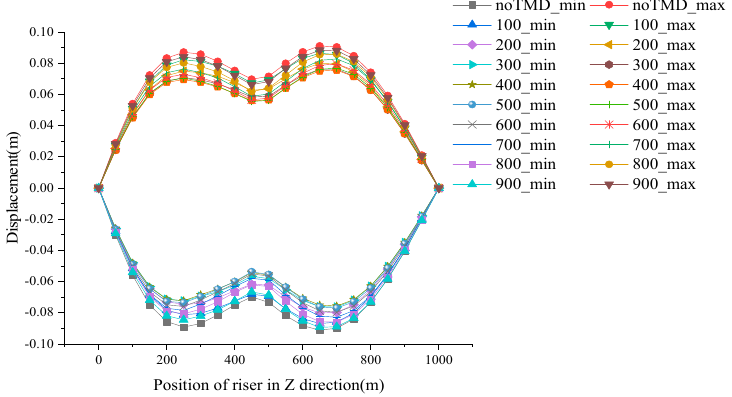
Figure 5. Envelope diagram of vibration displacement of the riser in the cross-flow direction when the TMD is installed at different positions.